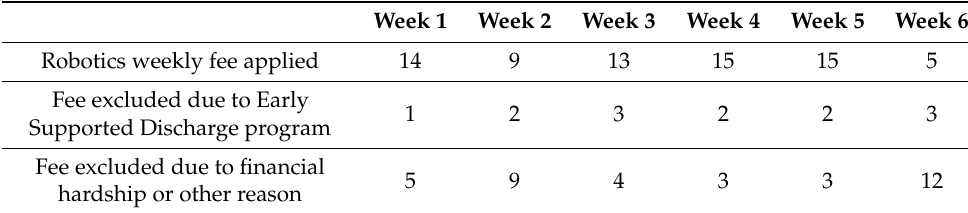
Table 9. Application of the robotics program weekly out-of-pocket